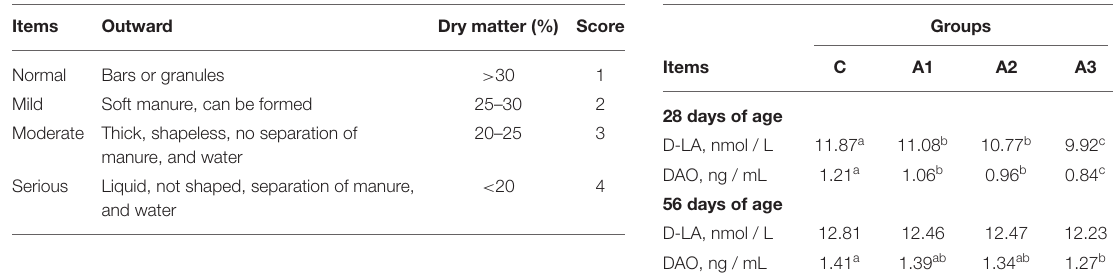
TABLE 1 | Fecal score standard. TABLE 3 | Effects of Anemoside B4 on serum indices of suckling